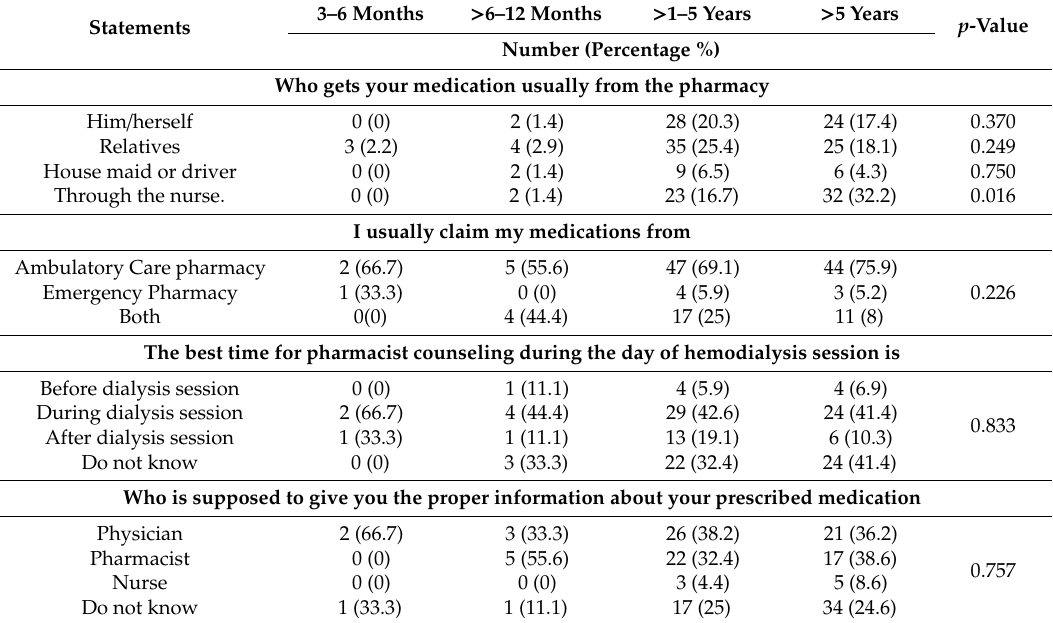
Table 3. Patient preference and thoughts vs. years on